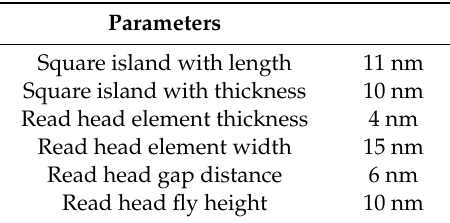
Table 2. Read head and pulse response